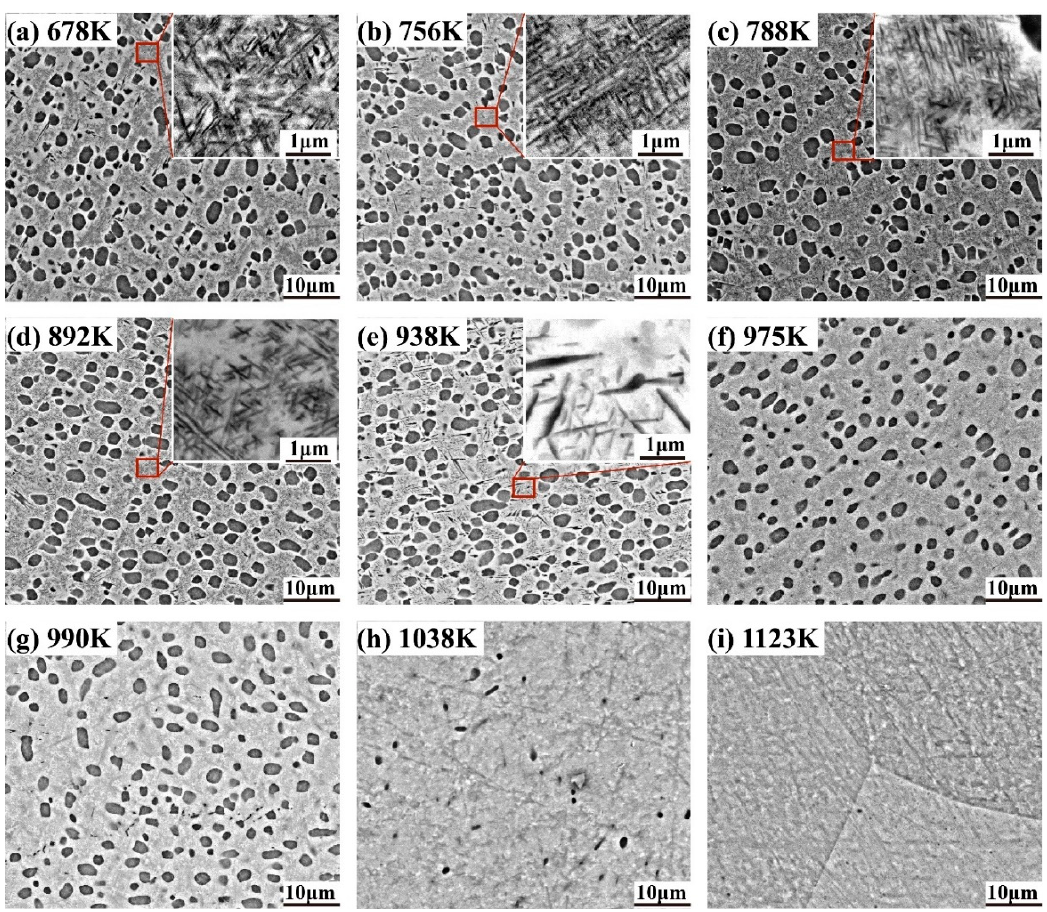
Figure 3. The microstructure of frozen bimodal Ti-55531 at ( a ) 678 K, ( b ) 756 K, ( c ) 788 K, ( d ) 892 K, ( e ) 938 K, ( f ) 975 K, ( g ) 990 K, ( h ) 1038 K, and ( i ) 1123 K during 1 K/min heating.